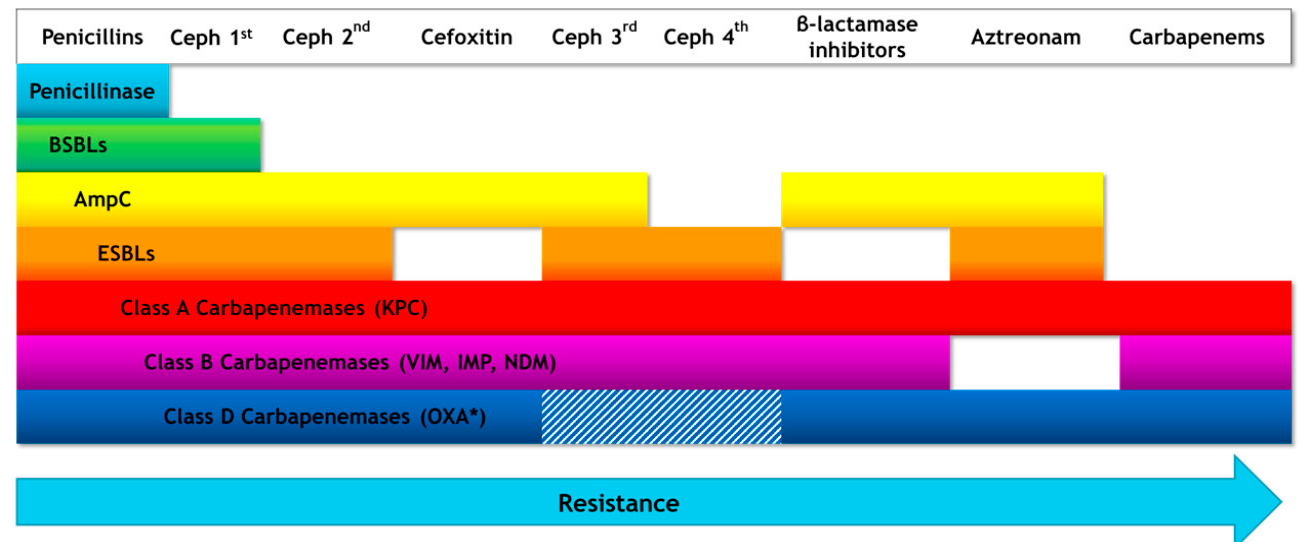
Figure 2. The degradation pattern for each type of β -lactamase. Cefoxitin is displayed differently from other 2nd generation cephalosporins, as hydrolysis of cefoxitin can be used to differentiate AmpC (hydrolyzes cefoxitin) from ESBLs (do not hydrolyze cefoxitin). * The different shading in the Class D carbapenemases row represents that resistance of OXA-type carbapenemases to 3rd and 4th generation cephalosporins is variable, depending on the carbapenemase variant; OXA-48 and OXA-58 have no intrinsic activity against expanded-spectrum cephalosporins, while OXA-163 and OXA-146 hydrolyze expanded-spectrum cephalosporins [63,108]. Abbreviations: Ceph: cephalosporin; BSBL: broad spectrum β -lactamase; ESBL: extended spectrum β -lactamase; KPC, Klebsiella pneumoniae Carbapenemase; IMP, Imipenemase type carbapenemase; NDM-1, New Delhi metallo- β -lactamase; VIM, Verona integron-encoded metallo- β -lactamase; OXA, oxacillinase.